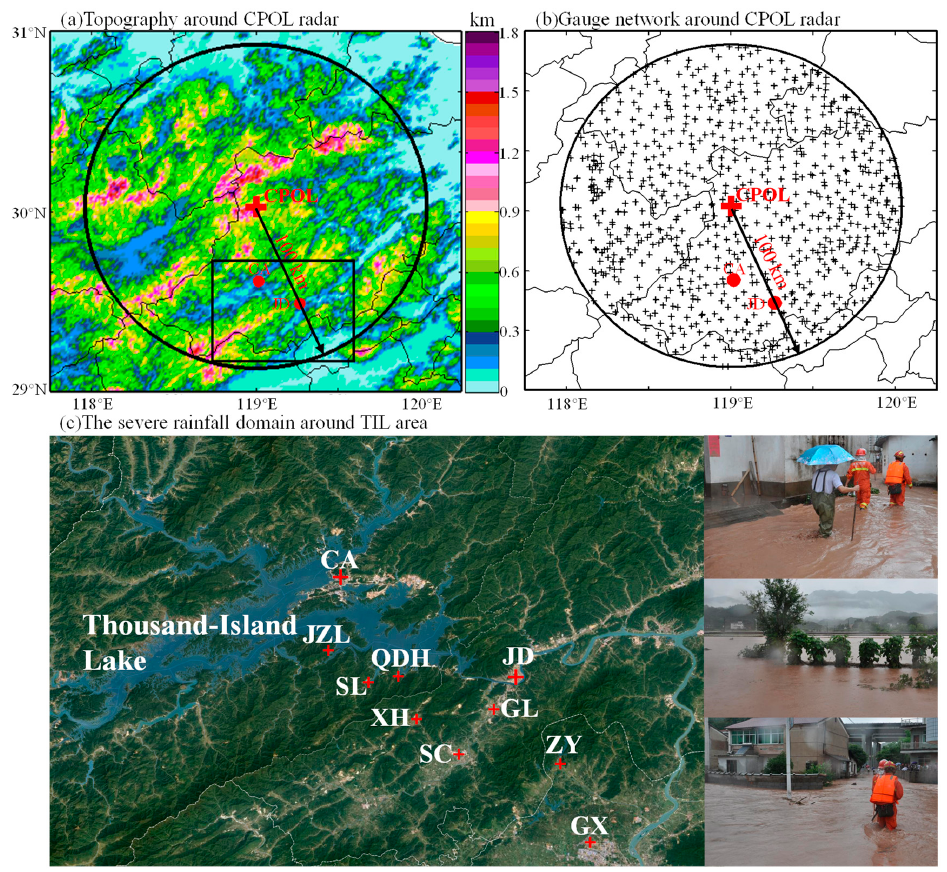
Figure 1. ( a ) Topography around the C-band polarimetric (CPOL) radar (red “+”); ( b ) gauge network (black “+”) within 100 km of the CPOL radar; the Parsivel 2 disdrometers deployed at CA and JD are marked with red dots on ( a ) and ( b ); ( c ) the severe rainfall domain (i.e., the rectangle in ( a ))